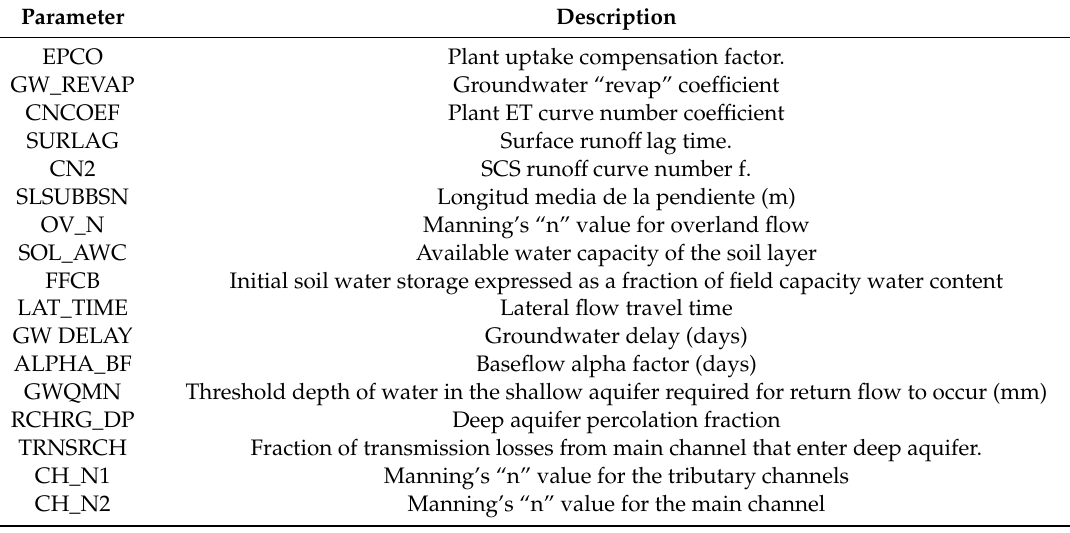
Table 2. Parameters used for the SWAT_CUP model sensibility